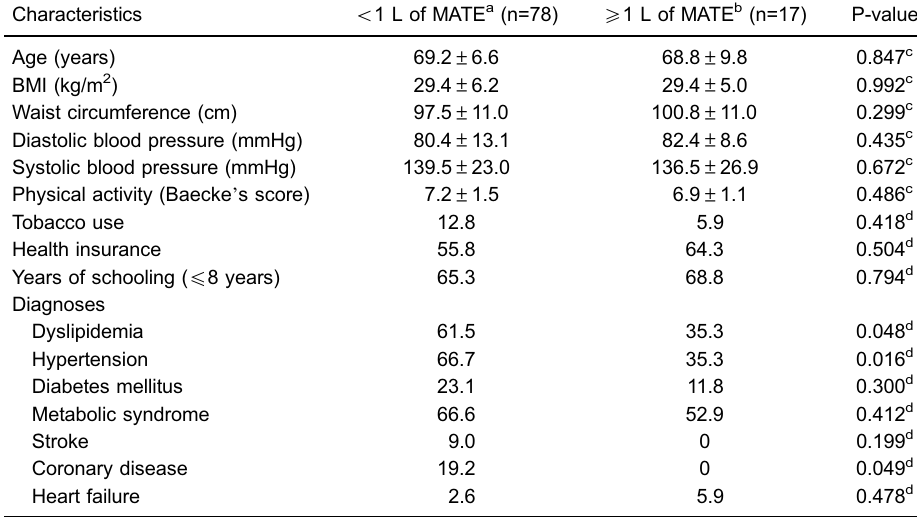
Table 1. Clinical characteristics of the studied women according to their daily intake of yerba